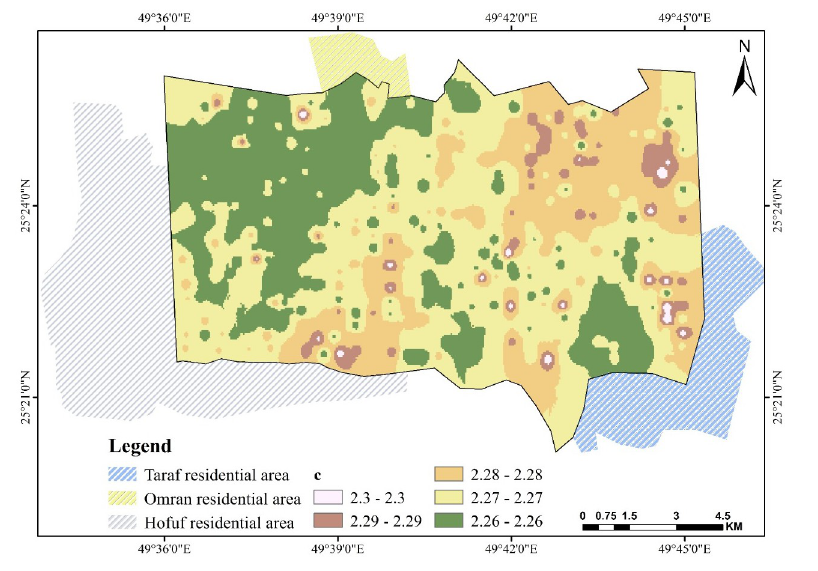
Fig 10. Spatial pattern of c over